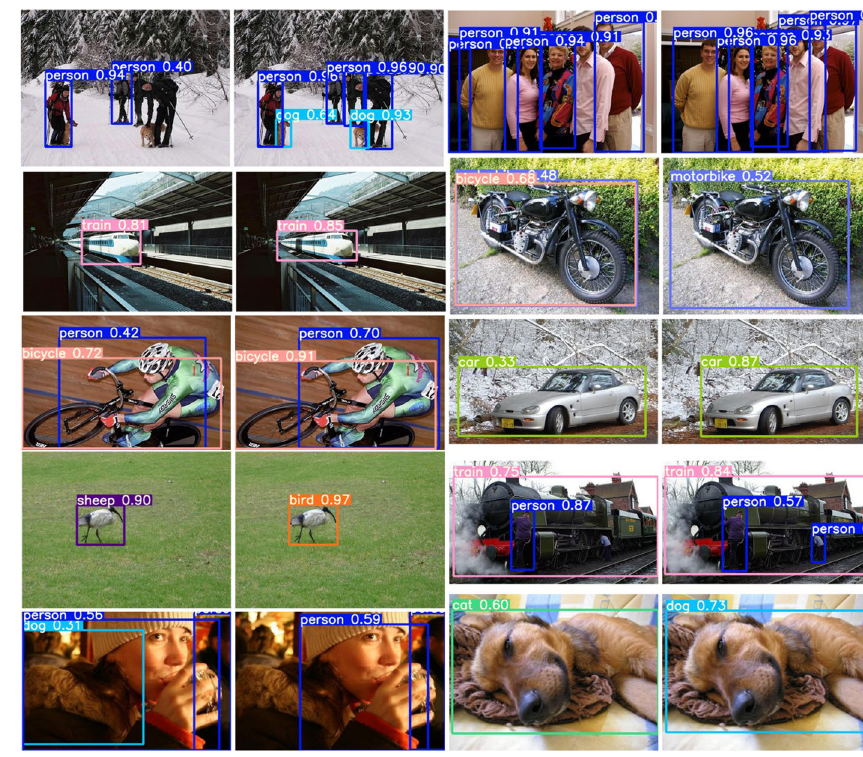
Fig. 8 Detection results using CIoU loss and IoAverage loss on the VOC2007 dataset